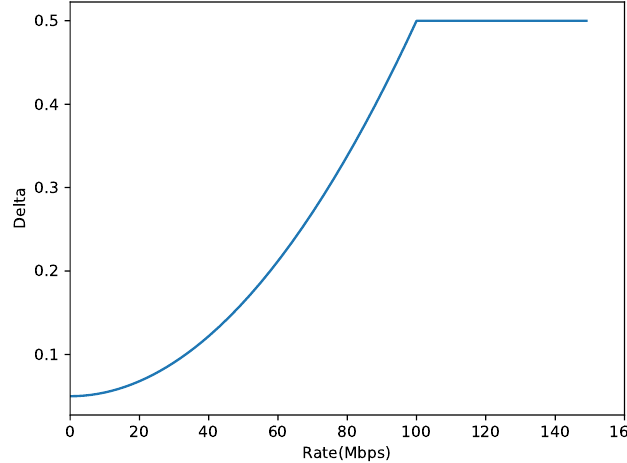
Figure 3. The relationship between δ and the transmission